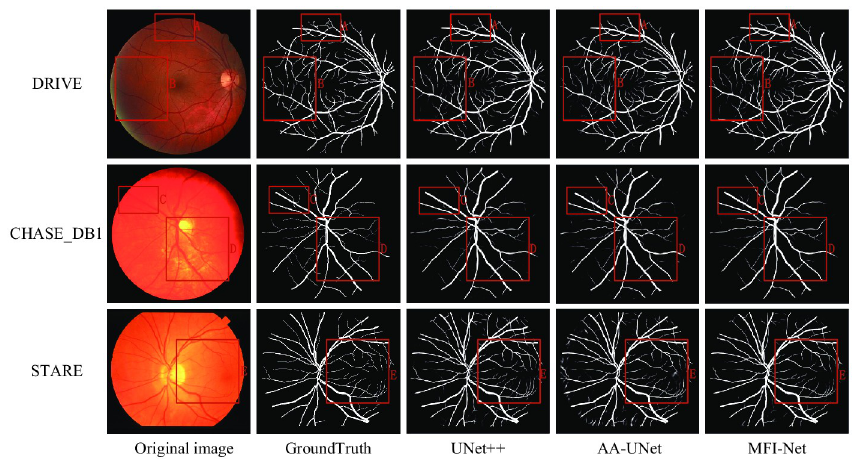
Fig 7. Comparison of segmentation results of MFI-Net(ours), UNet++ and AA-UNet. The red rectangles mark areas with obvious differences.